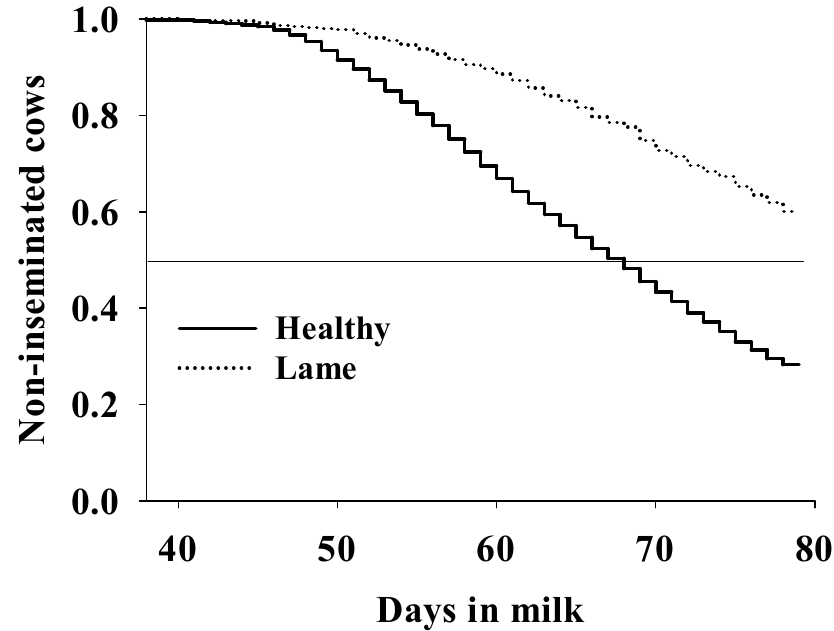
Figure 1. Association between lameness and calving to first service interval in grazing dairy cows (n: 7156) from a commercial dairy herd evaluated for 7.5 years (January 2010–June 2017). Healthy cows had a median (95%CI) calving to the first service interval of 69 (68–69) days; median survival days were not available for lame cows because they still had more than 50% of cows not inseminated by the end of data collection. Lame cows had a lower hazard of the first service than healthy herd mates (HR = 0.43, 95%CI = 0.39–0.48, p < 0.001). Lame: cows diagnosed as lame between calving and first service. Cows were diagnosed as lame when having a locomotion score of ≥ 4 [16]; healthy: cows not diagnosed as lame during the entire